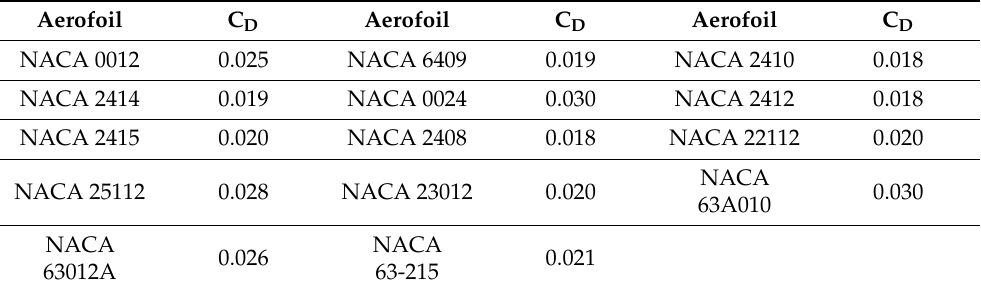
Table 9. Comprehensive coefficient of drag (C D ) analysis of various aerofoils. Aerofoil C D Aerofoil C D